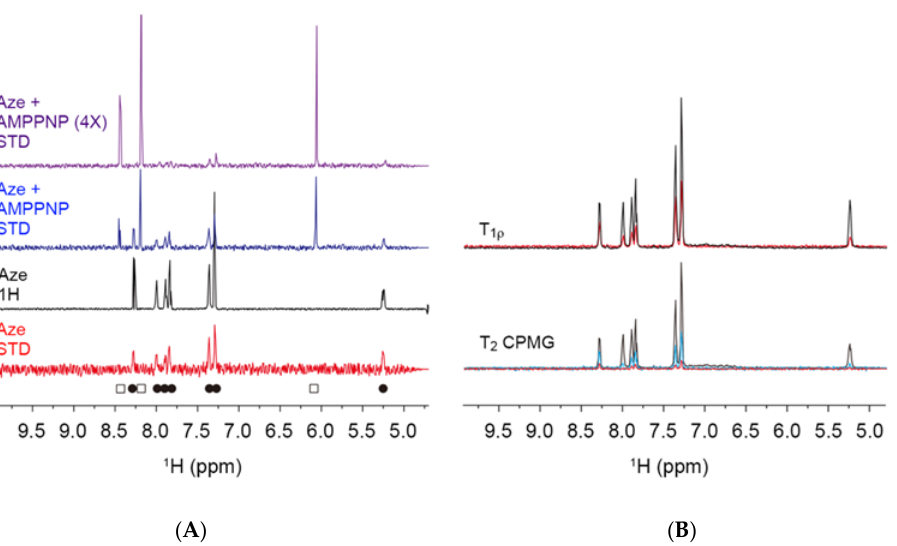
Figure 2. NMR spectroscopy indicating direct binding of Aze to JNK3. ( A ) STD NMR spectrum of Aze in the presence of JNK3 indicates the binding of Aze to JNK3 (red). The 1H NMR spectrum of Aze is shown in black. Aze binds to JNK3 in a competitive manner against AMPPNP (blue and purple). NMR signals from Aze are indicated with filled circles, and those from AMPPNP are presented with open squares at the bottom of the spectra. ( B ) In the T1 ρ -filter experiments, the spectrum with a 400 ms spin-lock delay (red) shows broader signals than that with a 10 ms delay (black). In the T2-filter experiments, relaxation delays were 8 (black), 80 (blue), and 240 (red), respectively. The broadened 1H signals of Aze in the experiments with longer relaxation delays (400 ms for T1 ρ and 240 ms for T2) indicate the direct binding of Aze to JNK3.